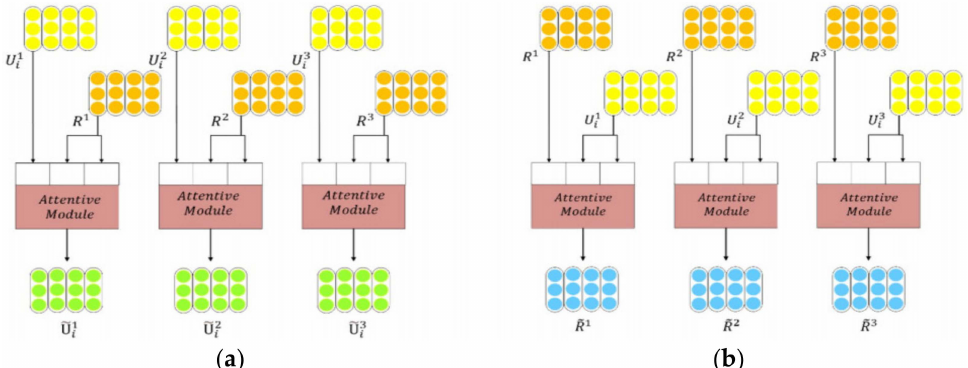
Figure 4. Shifted cross attention of multi-level granularity. ( a ) The granularity of utterance is used as the Q input to the Attentive Module, and the granularity of response is used as the K and V inputs to the Attentive Module; ( b ) The granularity of response is used as the Q input to the attentive module and the granularity of utterance is used as the K and V input to Attentive Module . Finally, two different granularities of cross-attention are generated.